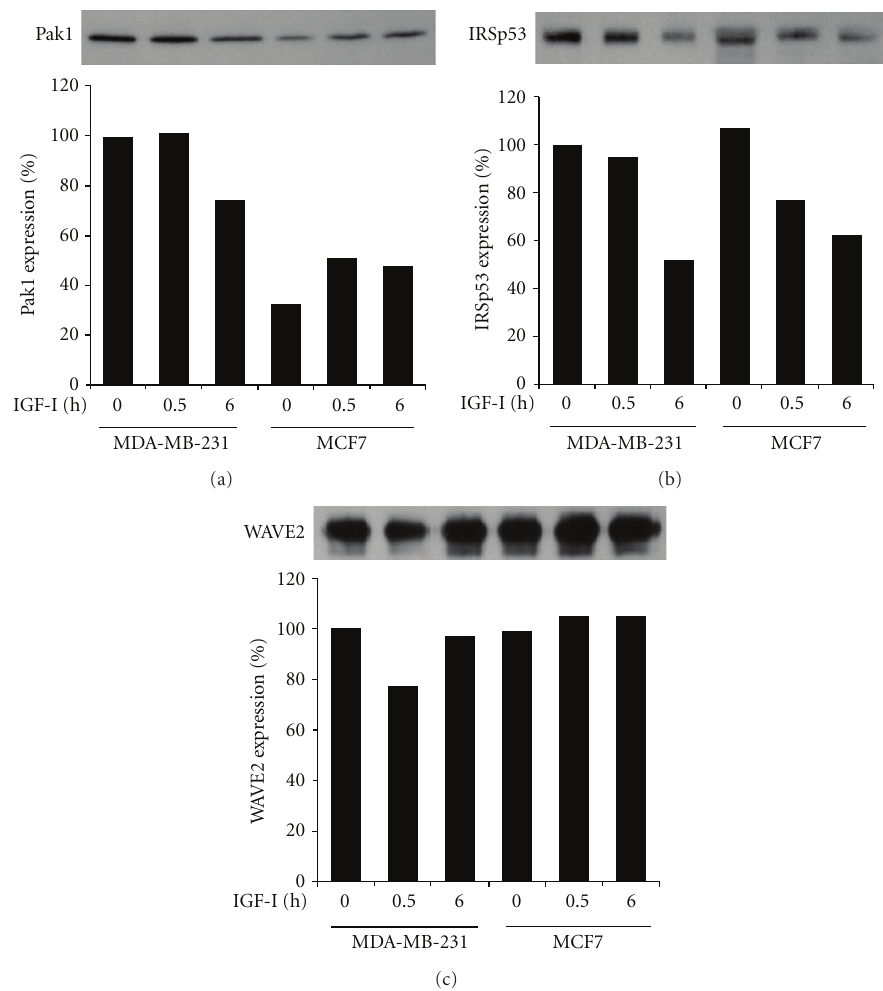
Figure 4: Expression of Pak1, IRSp53, and WAVE2 in MDA-MB-231 and MCF7 cells. After stimulation with IGF-I for 0, 0.5, or 6 h, cells were lysed and processed for immunoblotting with antibodies to Pak1 (a), IRSp53 (b), and WAVE2 (c). Band intensity relative to that in unstimulated control MDA-MB-231 cells is